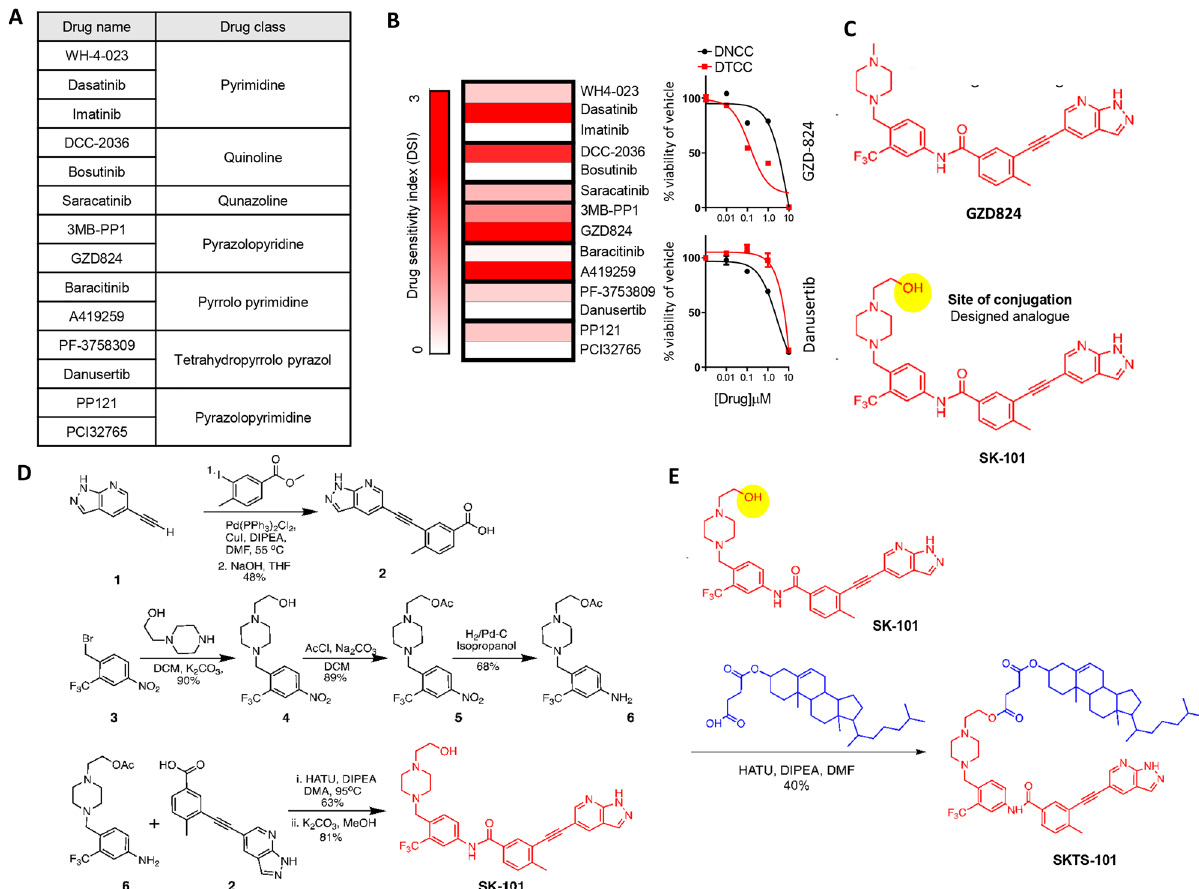
Figure 2: Selection of the drug candidate and introducing DTC targeting drug – lipid conjugate. (A) Collectionof kinaseinhibitingsmall molecules categorizedinto differentdrugclassesdepending ontheirchemicalstructure. (B)Heatmap representation of the drug sensitivity index (DSI) as determined in MDA-MB-231 cells. See Section 2 section for detailed calculation of DSI. Right panels show examples of high DSI (GZD824) and low DSI (Danusertib). (C) Structure of GZD824 and its modi fi ed analogue (SK-101). The modi fi ed analogue offers availability of site of conjugation where any targeting moiety can be attached highlighted in the bottom panel. (D) Synthetic scheme for SK-101. (E) Synthetic scheme of SKTS-101. Synthesis details in Supplementary material methods